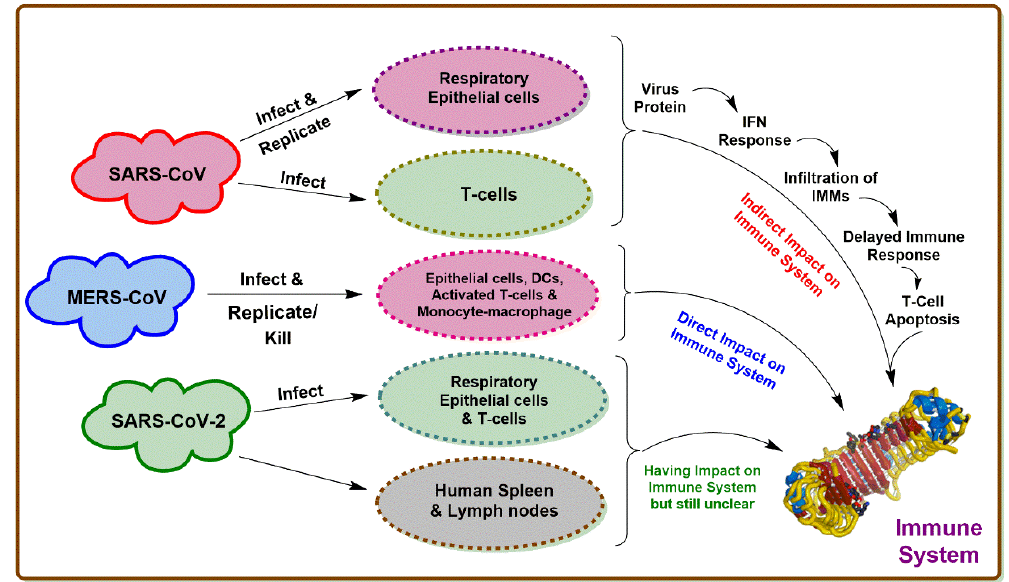
Figure 1: The difference between host cells among SARS-CoV-1, SARS-CoV-2, and MERS-CoV, and their impact on the immune